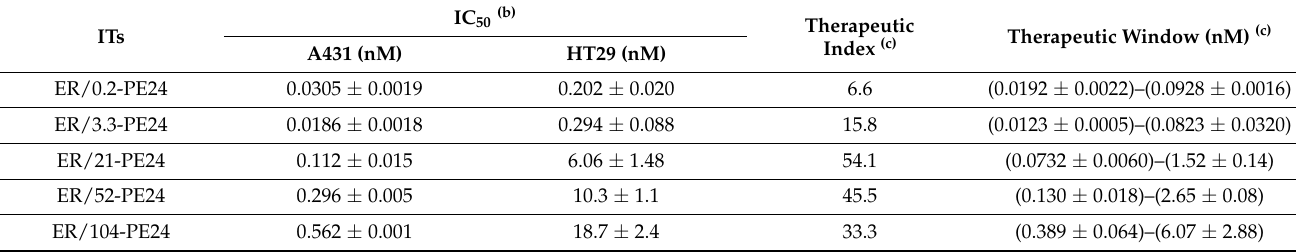
(a) The values of IC 50 and therapeutic window are represented as the mean ± SEM of three independent experiments. (b) IC 50 and IC 20 are the 50% and 20% inhibitory concentrations of cell viability, respectively. (c) The therapeutic index of each ER-PE24 was calculated by dividing [IC 50 against HT29 cells] by [IC 50 against A431 cells]. The therapeutic window of each ER-PE24 was estimated from the IC 20 values for A431 and HT29, i.e., [IC 20 against A431 cells]–[IC 20 against HT29 cells]. Each value represents the mean ± SEM of three independent